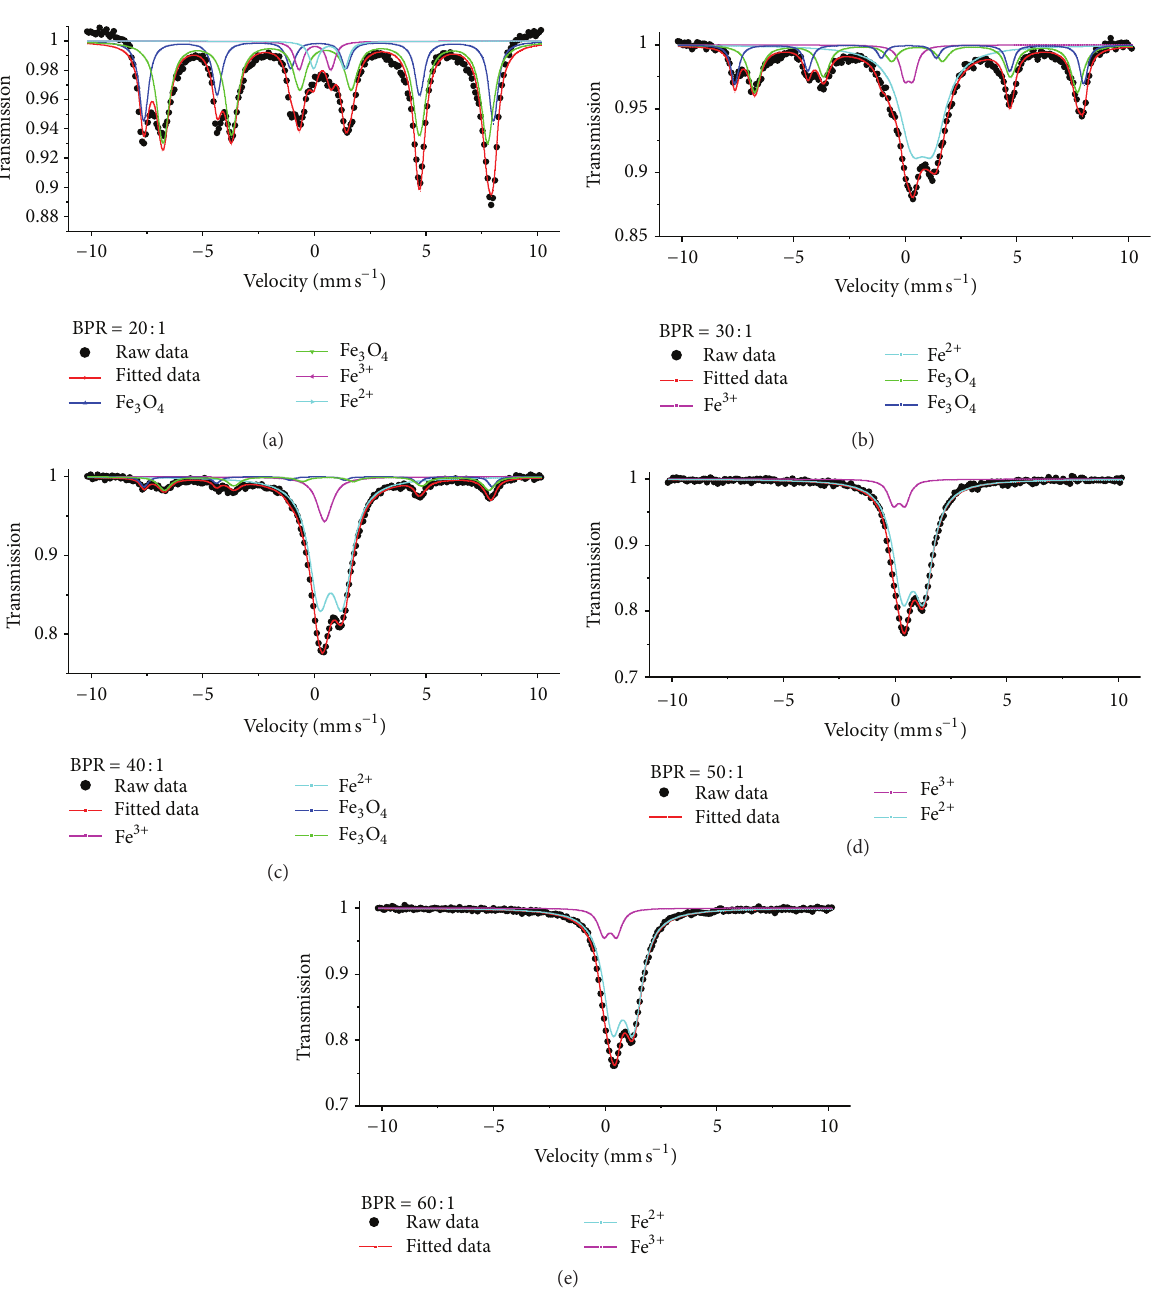
Figure 2: Room temperature MAS spectra of the ball-milled magnetite and graphite mixtures (1:3 mole ratio) at different ball to powder ratios (BPR), while rotational speed and milling periods were kept constant at 400rpm and 20 hours,